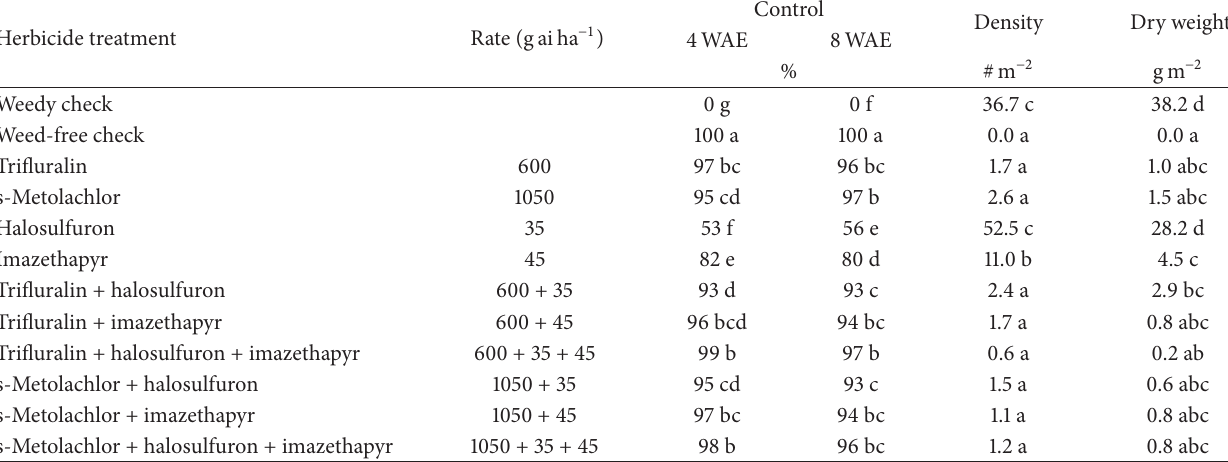
Table 6: Percent control, density, and dry weight of green foxtail in white bean treated with halosulfuron tankmixes applied PPI at Exeter, ON (2011–2013). Means followed by the same letter within a column are not significantly different according to Fisher’s Protected LSD at 𝑃 < 0.05 a . Herbicide